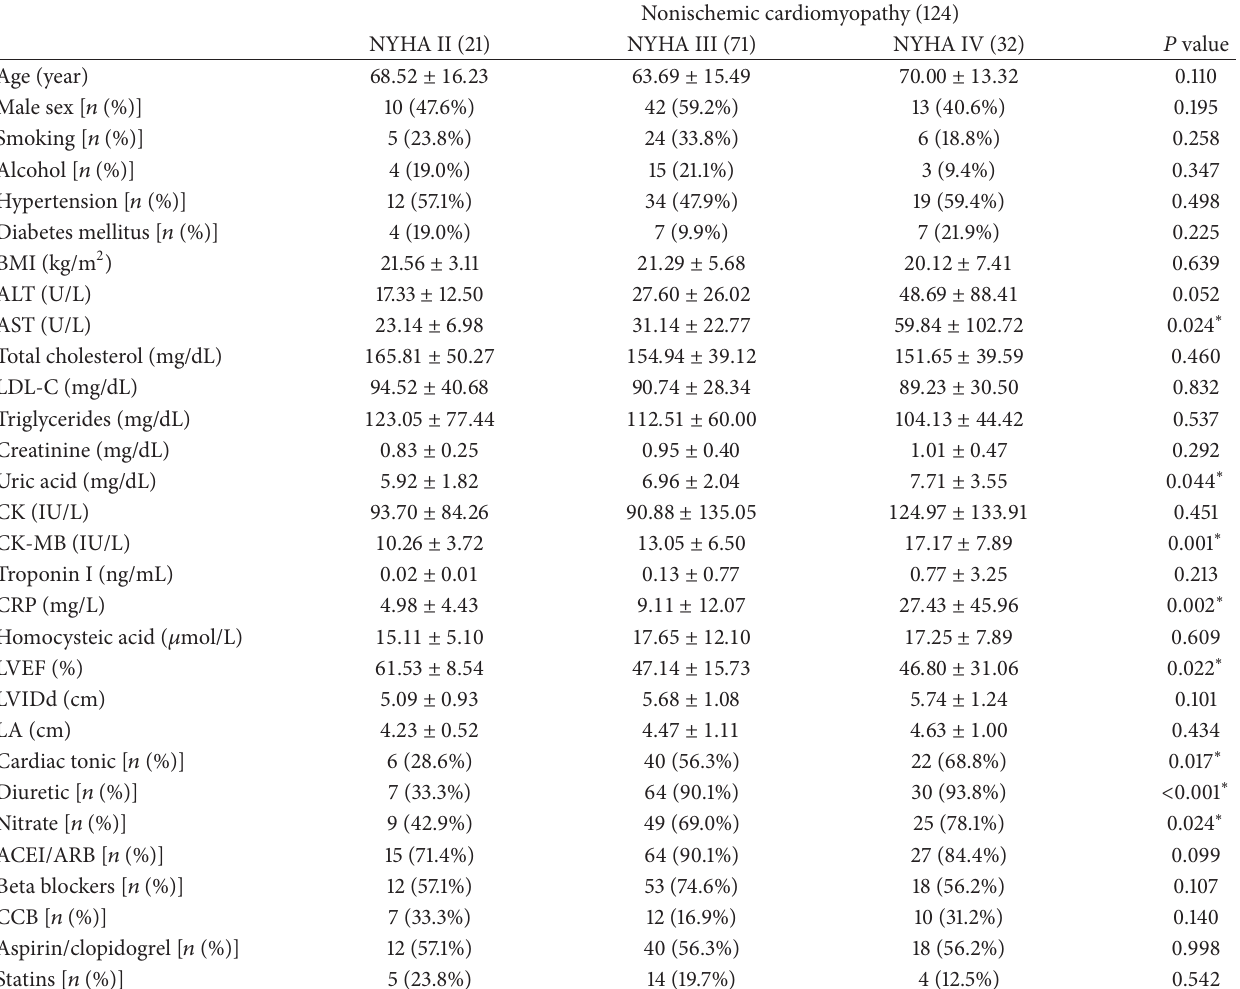
Table 3: Baseline characteristics of patients with nonischemic